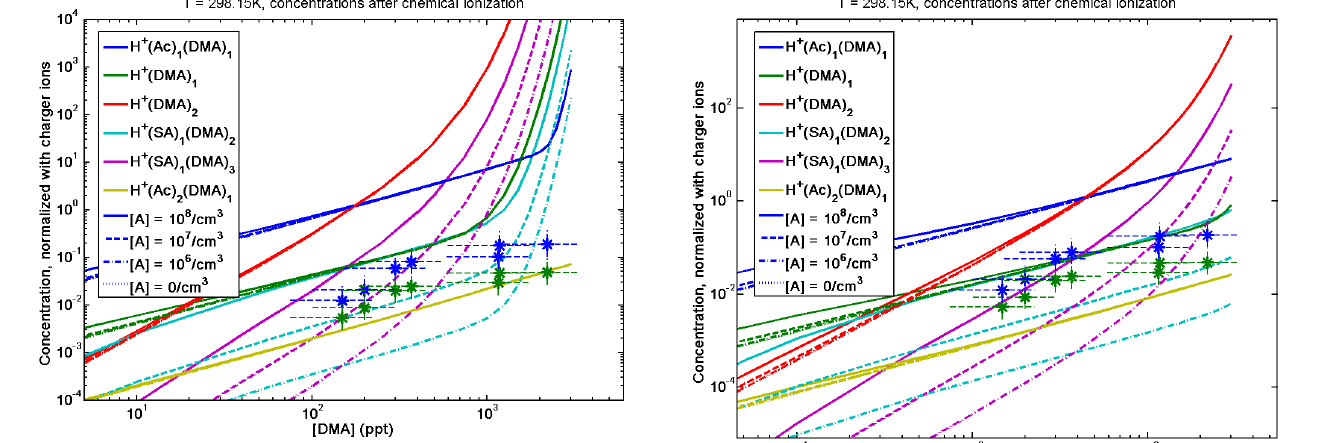
Figure 7. Modelled concentrations of charged clusters after chem- ical ionization, normalized with the remaining charger ion concen- tration after the ionization, ([H + (Ac) 1 ] + [H + (Ac) 2 ]). The stick- ing factor was 1 for all collisions, the neutral acetone monomer concentration was 0cm − 3 , and the initial charger ion concentra- tion was 10 6 cm − 3 . The stars represent the CI-APi-TOF measure- ment data, presented as the normalized average signals of ion counts per second. Green stars are for H + (DMA) 1 and blue stars are for H + (Ac) 1 (DMA) 1 . The error bars in the direction of the x axis are calculated using known sources of error and propagation of uncer- tainty. The error bars in the direction of the y axis represent the uncertainty in ion transmission coefficients.